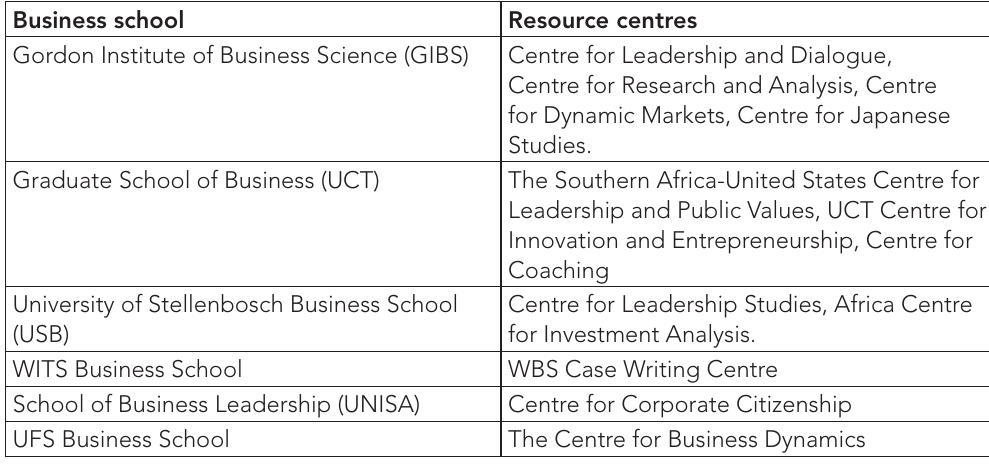
Table 9: Resource